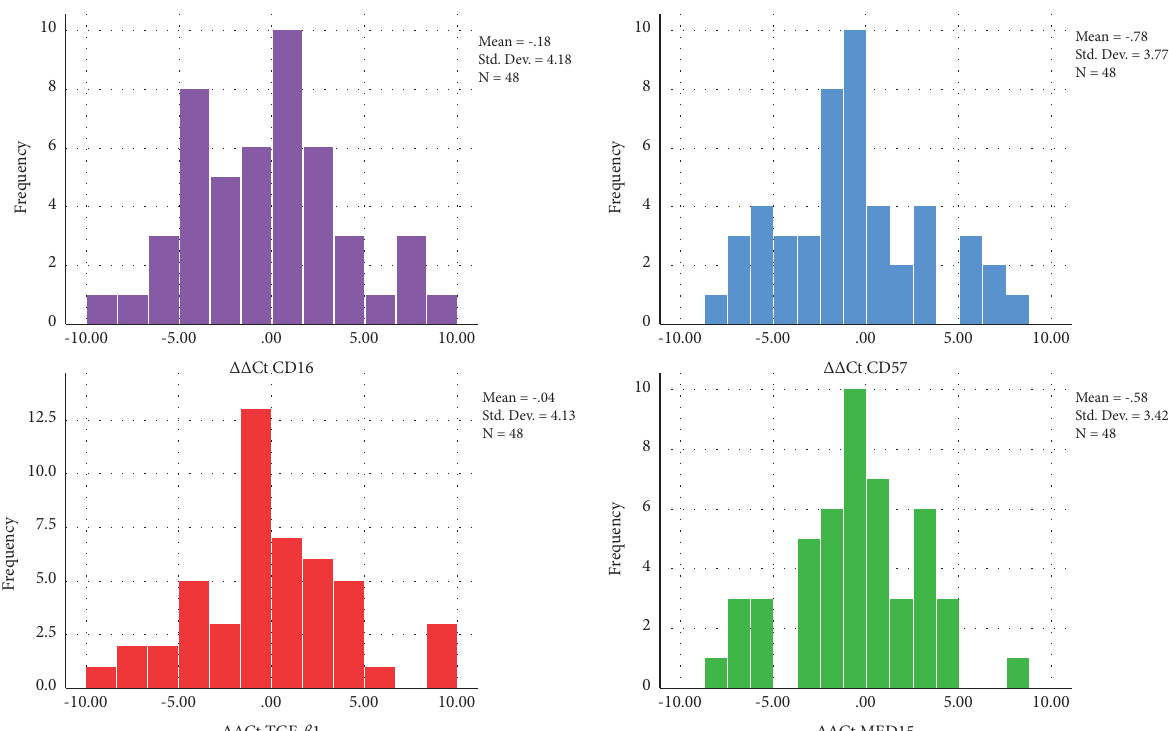
Figure 1: Histograms of ΔΔ Ct values along with descriptive